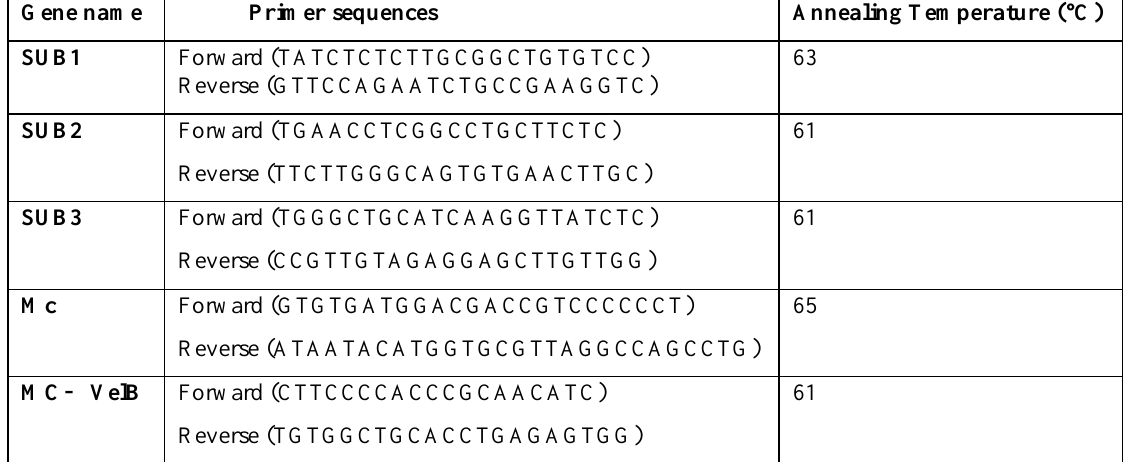
Table 1. Target genes with their primer sequences and annealing temperatures used in PCR